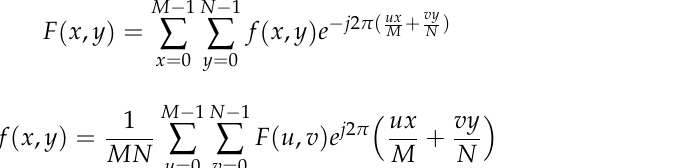
Figure 4. Structure of FFM.